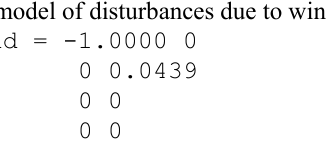
Fig. 4. The result of modeling a stabilization system without disturbances using the step (sys)